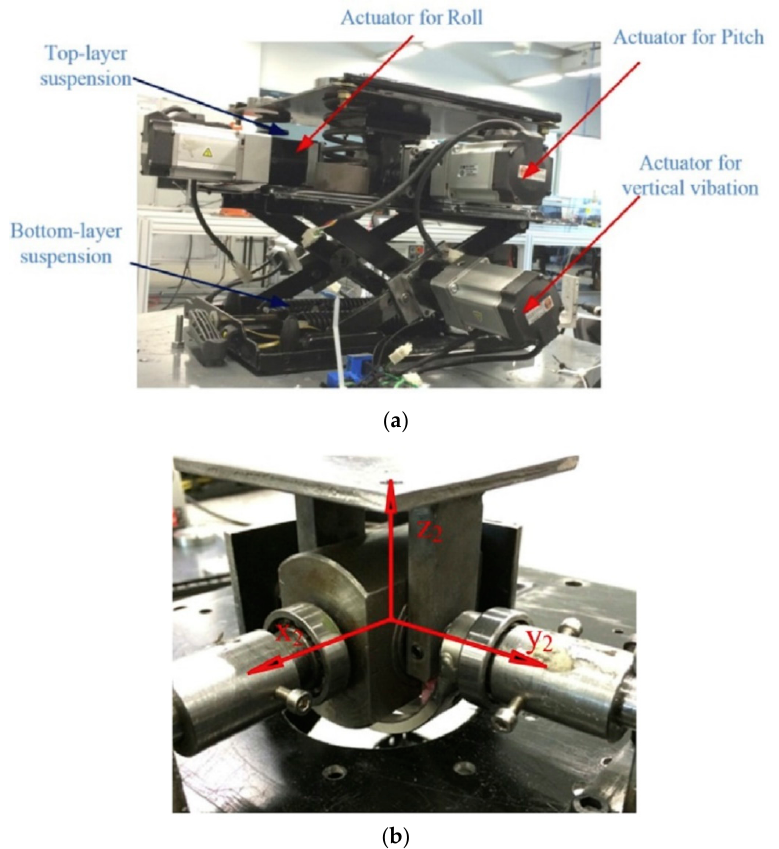
Figure 15. (a) The double-layer seat suspension prototype with multi-DOF vibration control Figure 15. ( a ) The double-layer seat suspension prototype with multi-DOF vibration control mechanism mechanism (b) The universal joint [61]. ( b ) The universal joint